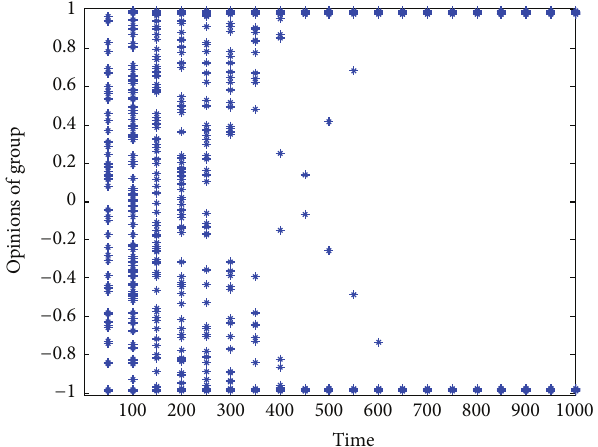
Figure 7: Group opinions change with time. 𝑎 = 1 , 𝑏 = 𝑐 = 0 , and 𝑥 = ±1 (discrete